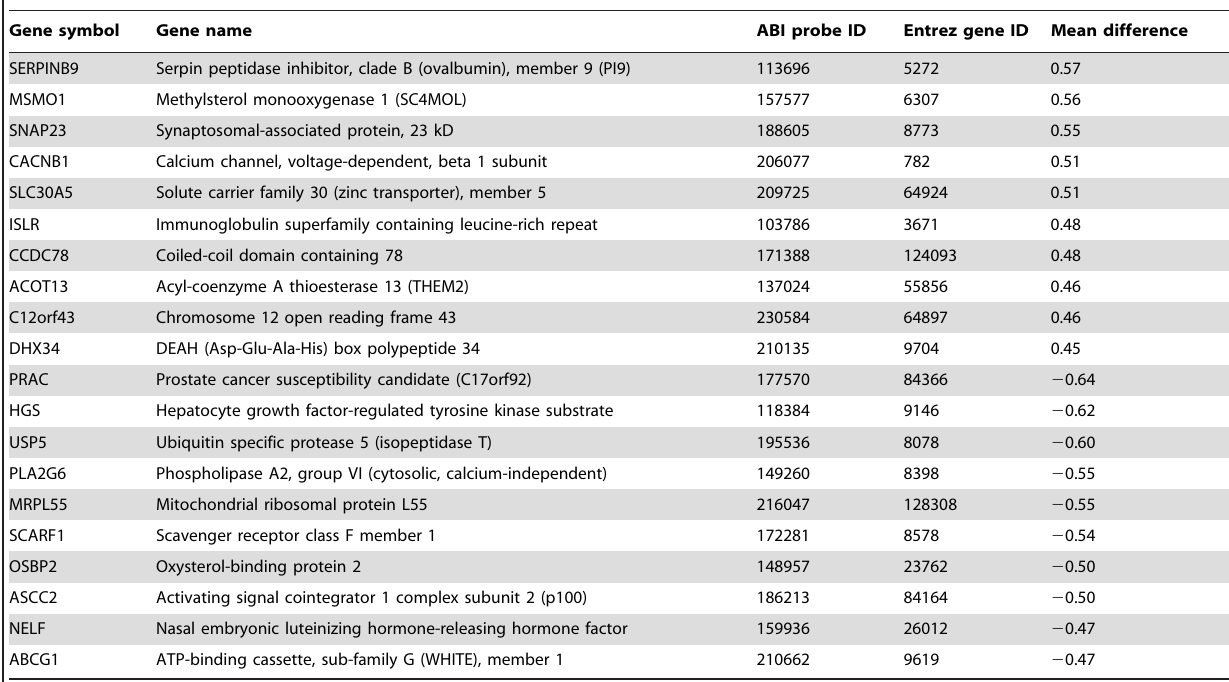
Table 6. Top 10 up- and down-regulated genes associated with total n-6/n-3 ratio (p # 0.01) a .